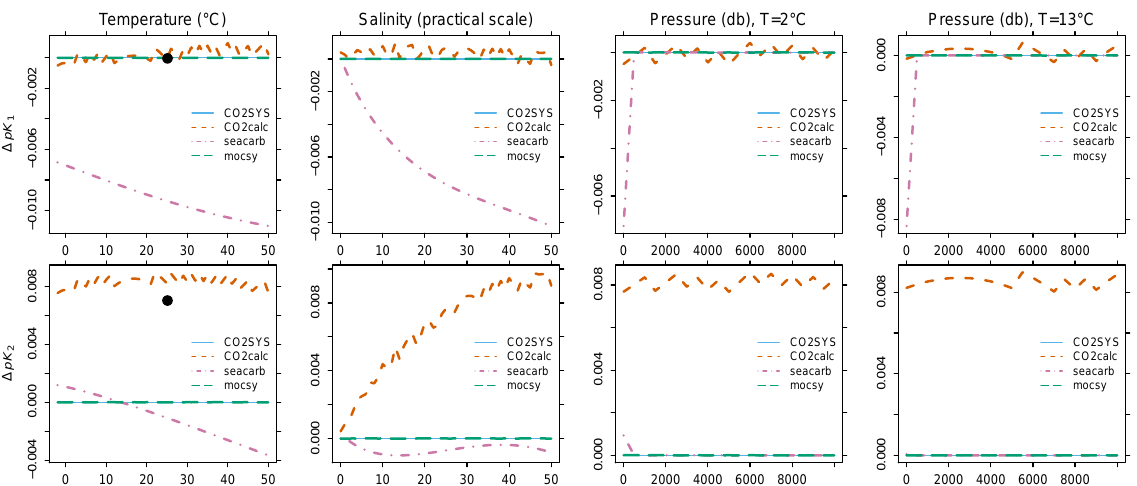
Figure 14. The p K 1 (top) and p K 2 (bottom) computed in each of four packages minus corresponding values for CO2SYS-MATLAB, as in Fig. 13 except that formulations are from Millero (2010), not Lueker et al. (2000). The filled black circles indicate the check values (Table 12). Six packages include this option. Only CO2SYS-MATLAB, CO2calc, seacarb, and mocsy are shown. Both CO2SYS Excel variants agree with the reference, but when CO2SYS-Excel-Pelletier is switched from the published to the unpublished seawater-scale coefficients, it resembles